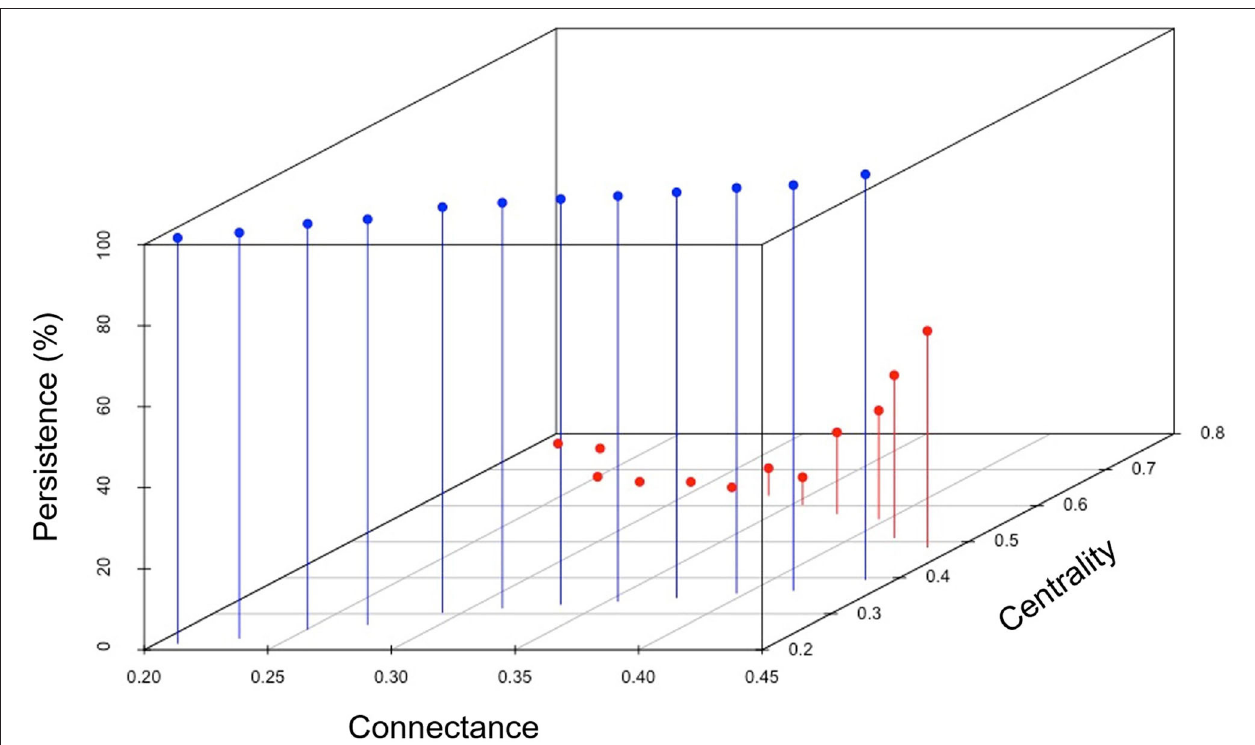
FIGURE 9 | Relationship of the percentage of persistence of the final networks with the centrality and connectance of the initial networks, along the link up path (red dots) and the link down path (blue